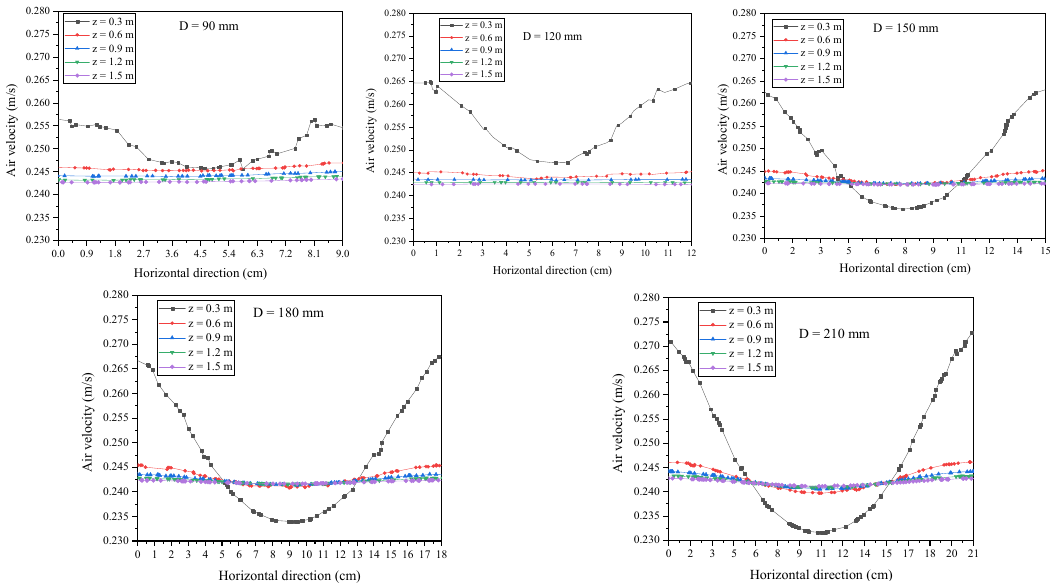
Figure 12. Air velocity variation along the horizontal direction at different orifice spacings.